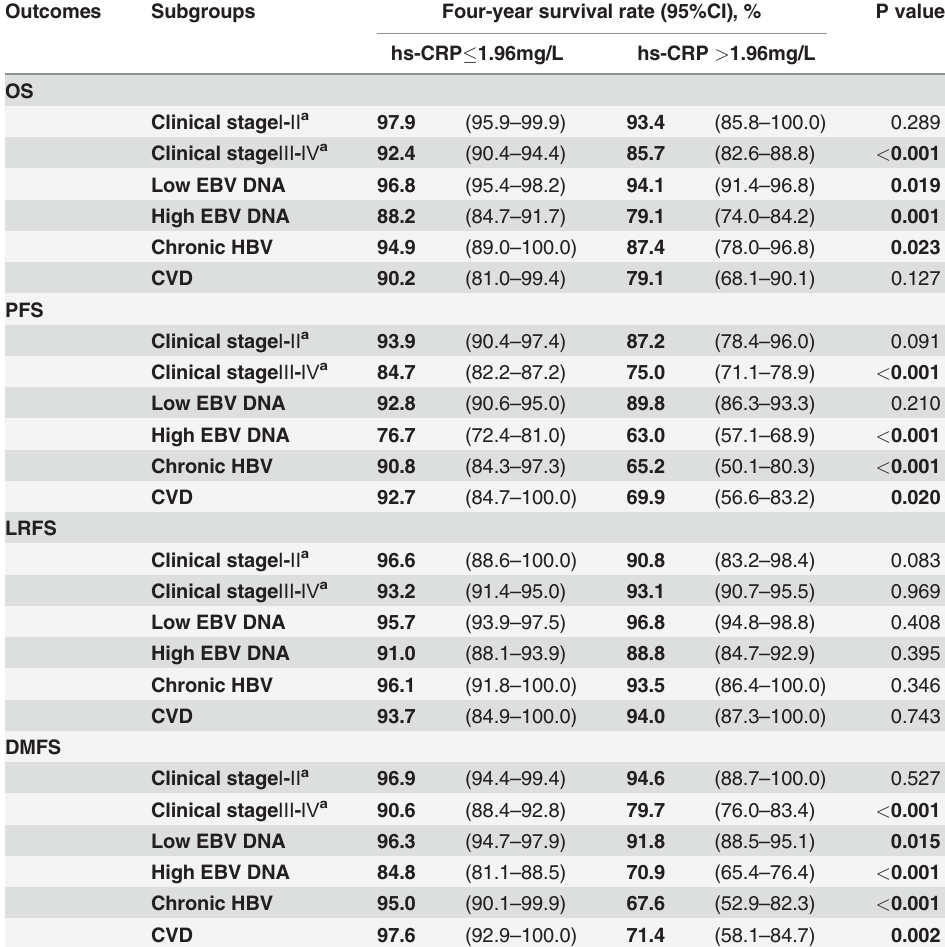
Table 3. Four-year survival rate for patients in specific